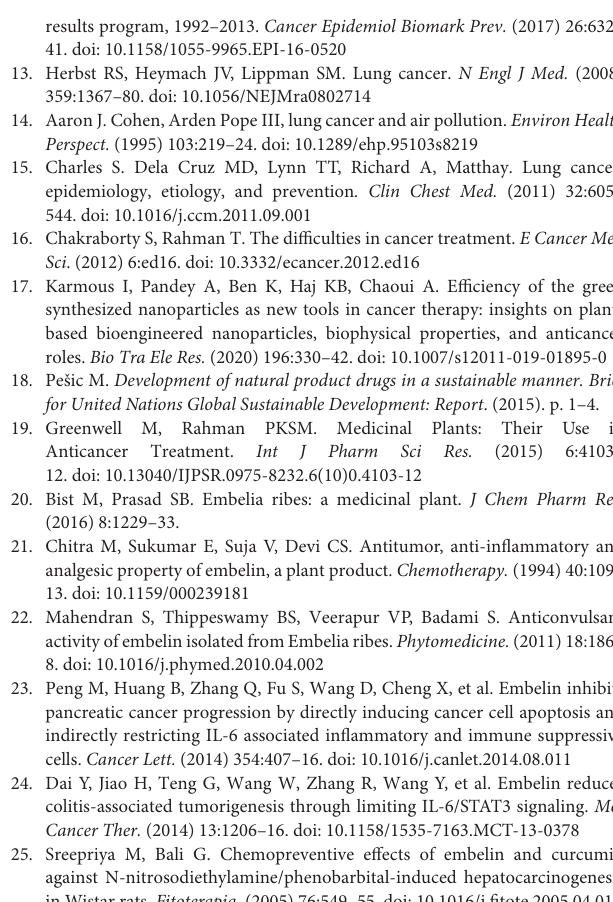
Supplementary Figure 1 | FT-IR spectrum of embelin. Supplementary Figure 2 | 1 H NMR spectrum of isolated embelin. Supplementary Figure 3 | UV-visible spectrum of embelin-derived AgNPs. Supplementary Figure 4 | (A) Cross-correlation for particle size analysis [NANOPHOX (NX0088)]; (B) zeta potential of embelin AgNPs. Supplementary Figure 5 | FT-IR spectrum of embelin-derived